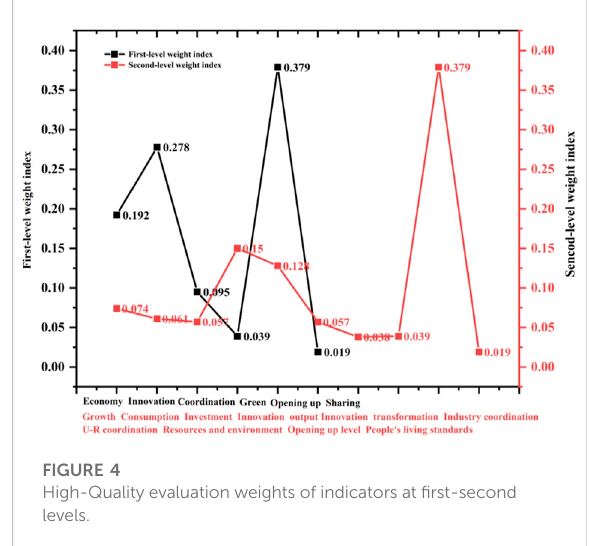
FIGURE 4 High-Quality evaluation weights of indicators at fi rst-second